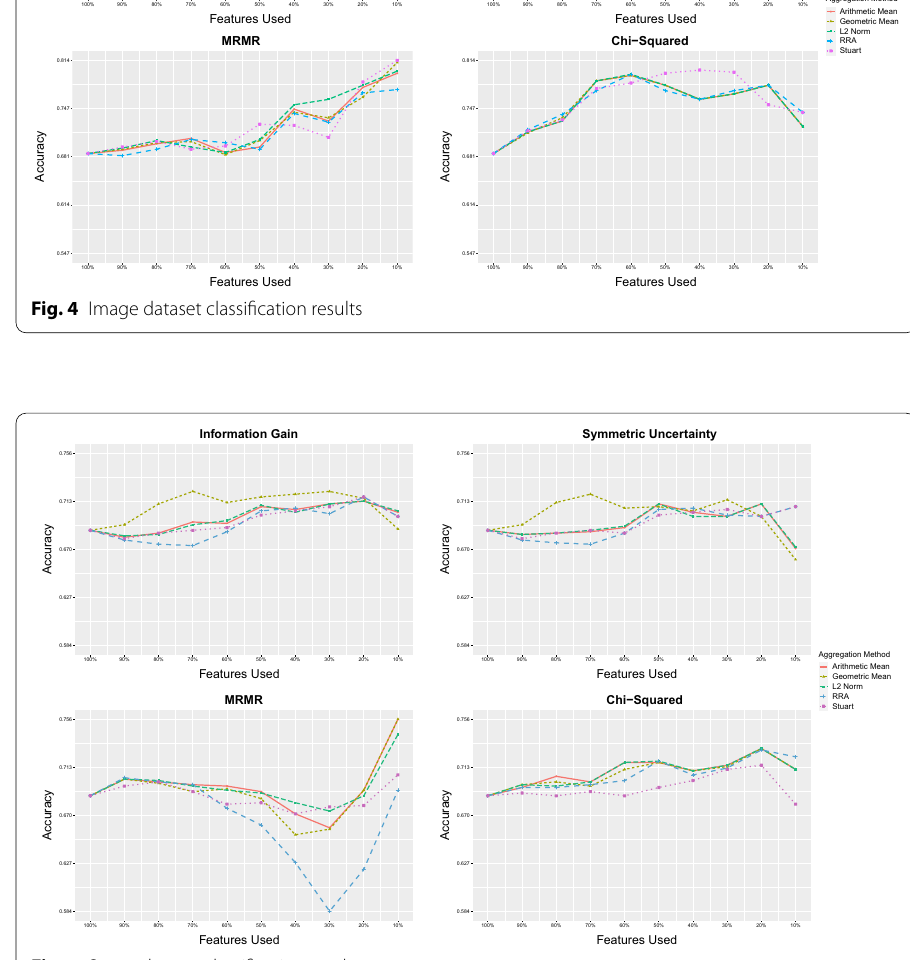
Fig. 5 Scene dataset classification